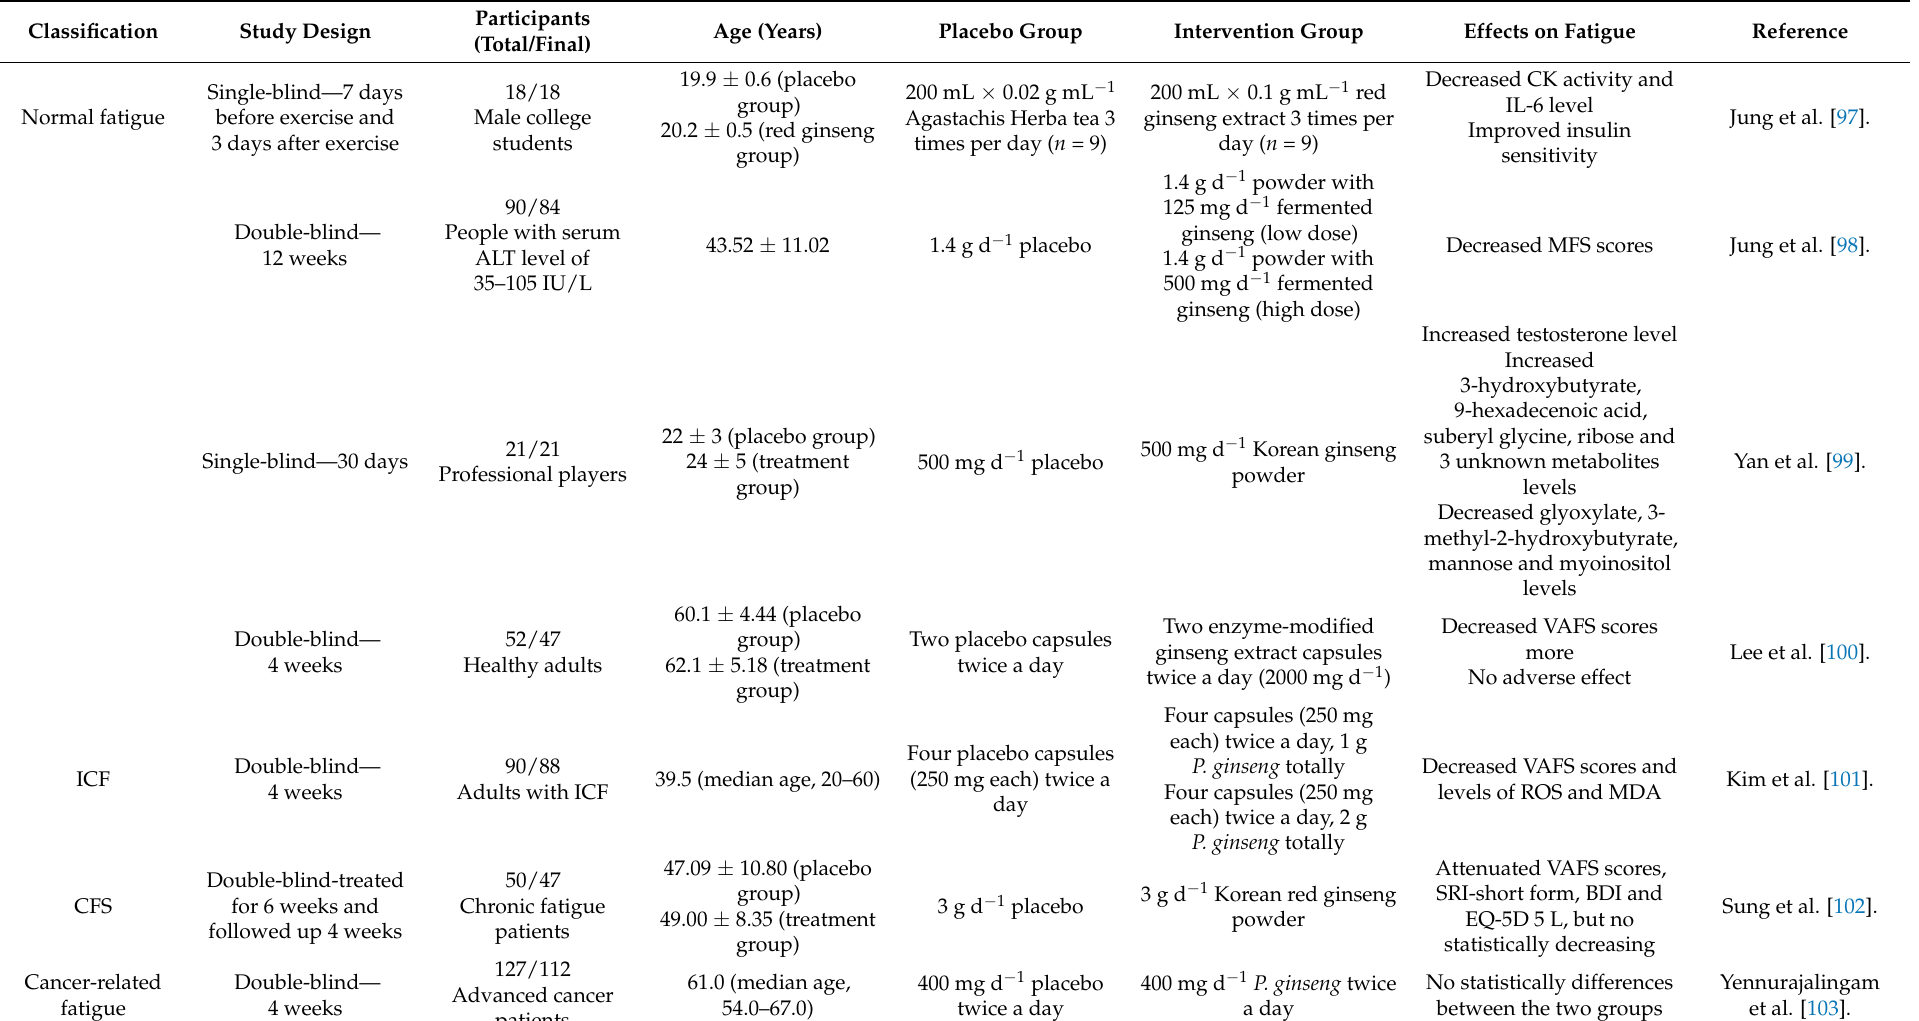
Table 3. Anti-fatigue of P. ginseng in clinical